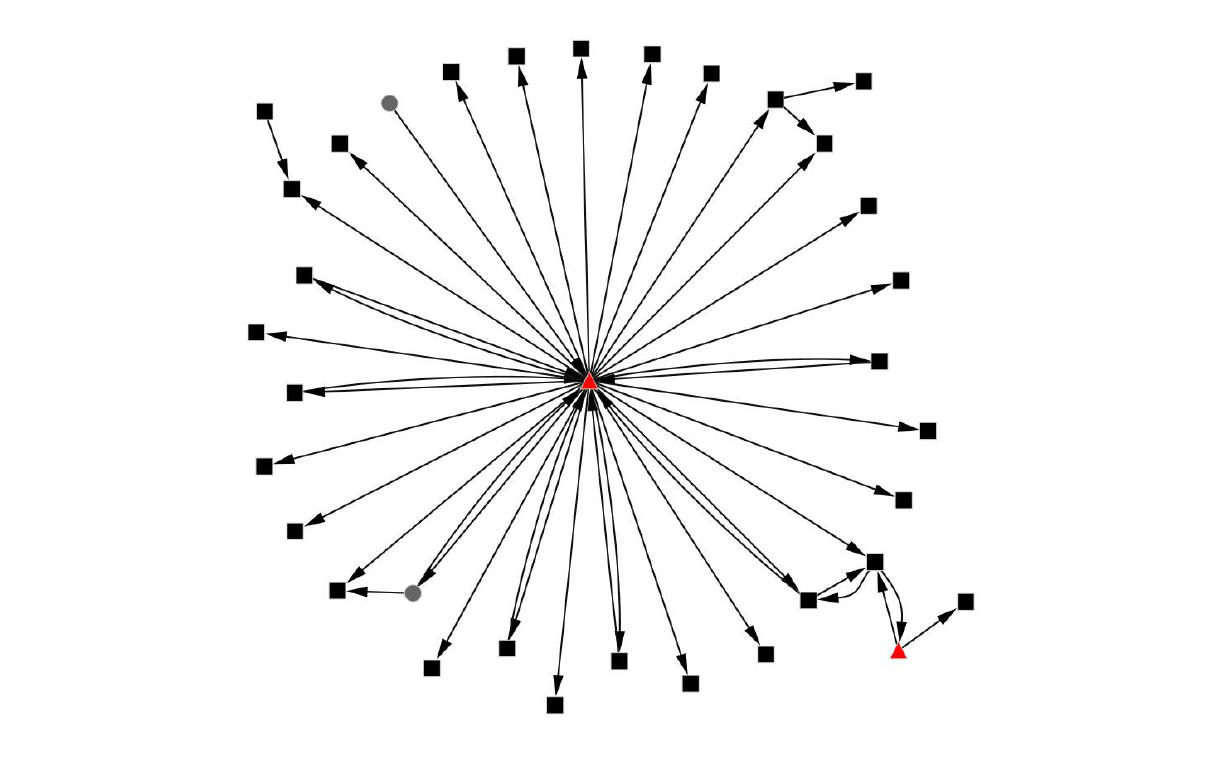
Figure 1. Networks for the Women’s Health forum. Black squares are female, grey circles are male, the Healthy.me GP and/or counselor is represented in the red triangle.